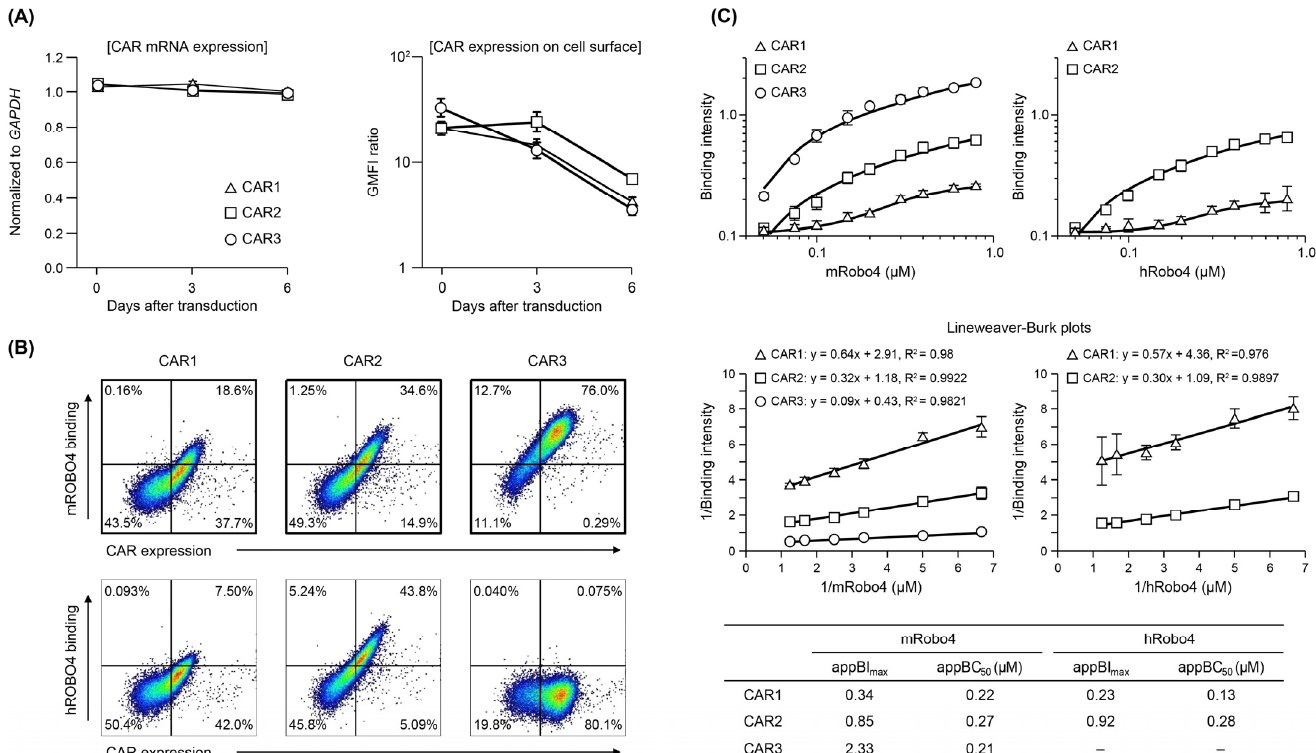
Figure 2. Expression and binding affinity of anti-Robo4 CARs with three different ARDs. ( A ) CAR mRNA expression analyzed using RT-qPCR, normalized to that of Gapdh mRNA. Cell-surface CAR measured by flow cytometry (FCM). Cells were pregated with live cells, lymphocytes, and CD8 α + cells. Geometric mean fluorescence intensity (GMFI) ratio was calculated as GMFI by anti-HA antibody/GMFI detected by isotype controls. ( B ) Binding to m/hRobo4 protein by anti-Robo4 CARs measured using FCM. Cells were pregated with live cells, lymphocytes, and CD8 α + cells. ( C ) Binding of CAR-T cells to mouse and human Robo4 measured using FCM. Binding intensity refers to the ability to bind m/hRobo4 per unit CAR expression. The apparent maximum binding strength (appBI max ) and apparent 50% binding concentration (appBC 50 ) values were calculated using Lineweaver – Burk plots.